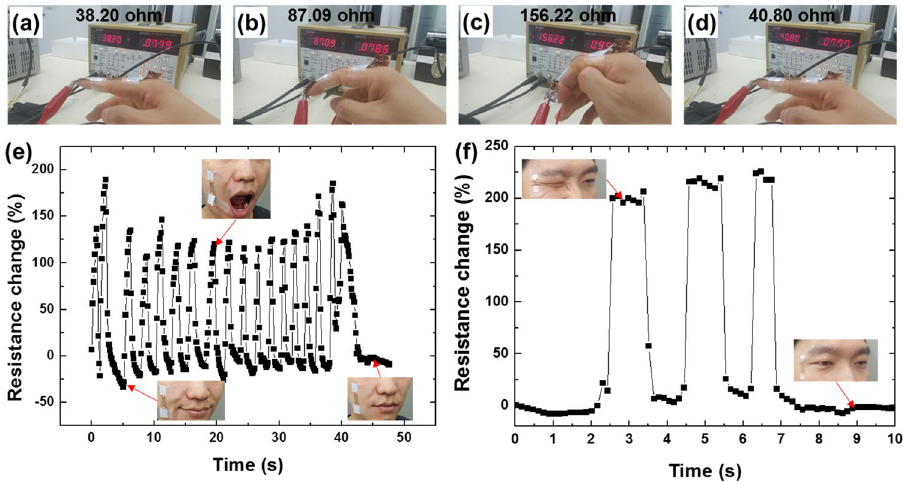
Figure 7. Resistance of the crack-induced sensor attached to the skin ( a – d ) around a proximal interphalangeal joint, ( e ) around a human cheek, and ( f ) a lateral area of a human